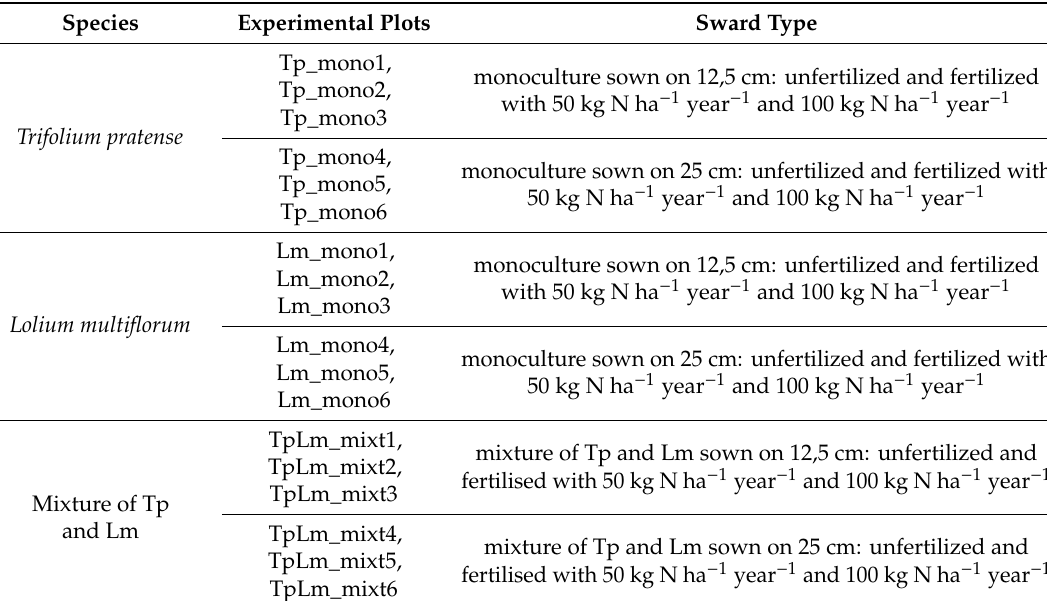
Table 2. The studied sward